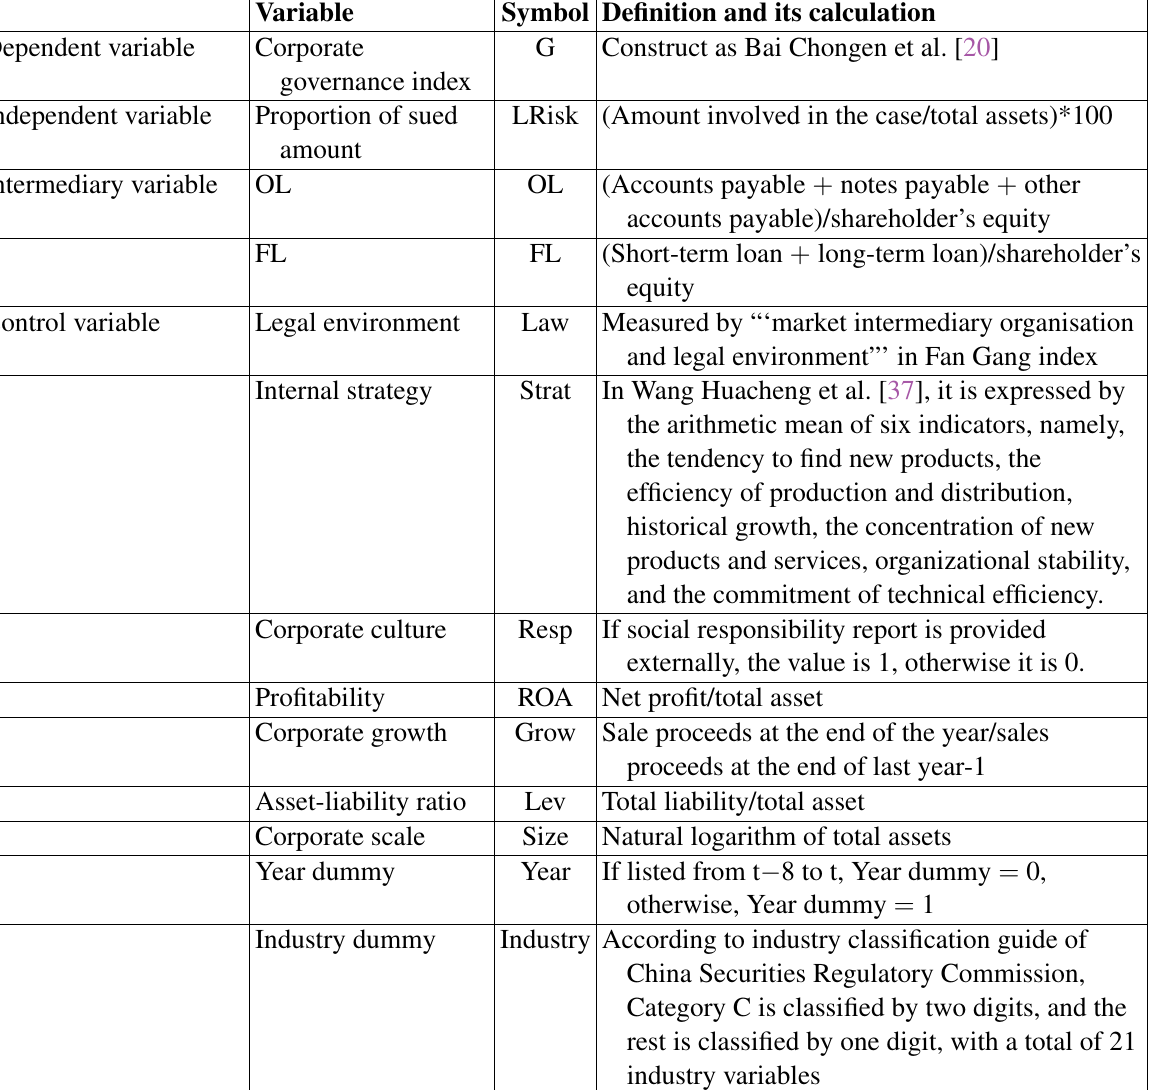
Table 1 Main variable definition and its